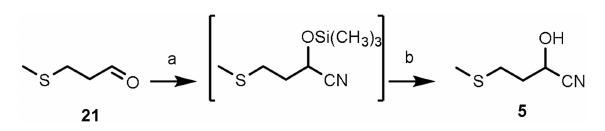
FIGURE 9 | Chemical synthesis of 2-hydroxy-4-(methylthio) butanenitrile (5). Reagents and conditions : (a) Trimethylsilyl cyanide [TMSCN: (CH 3 ) 3 SiCN], solid lithium perchlorate (LiClO 4 ), room temperature (r.t.), 2h, quantitative; (b) THF, HCl(3 M), 65 ◦ C, 1h, 84% overall